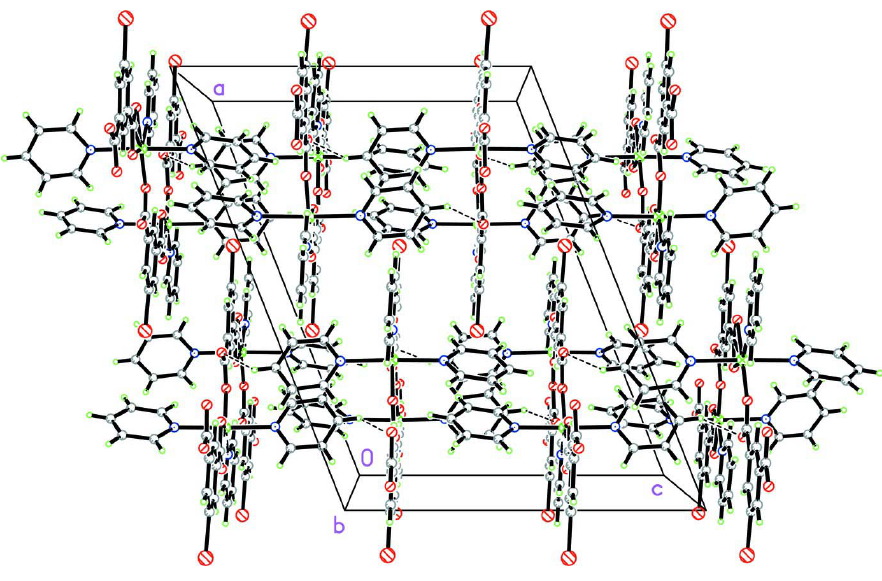
Figure 1 Molecular structure showing 50% probability displacement ellipsoids. The unlabeled atoms are derived from the reference atoms by means of the (1.5 - x , -1/2 + y , 1.5 - z ) symmetry transformation..